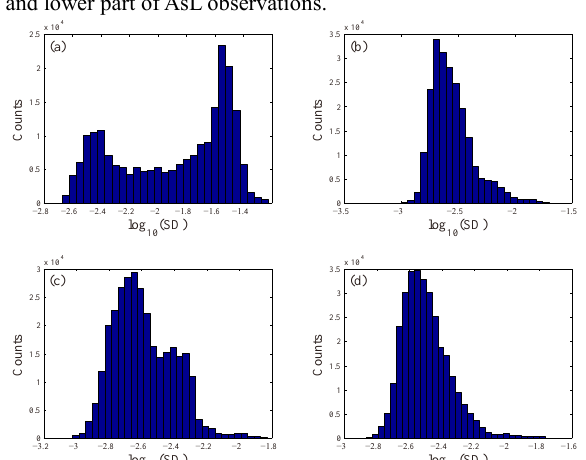
Figure 4. Histograms of the estimated SDs with respect to (a) ascending left-looking, (b) ascending right-looking, (c) descending left-looking and (d) descending right-looking observations,